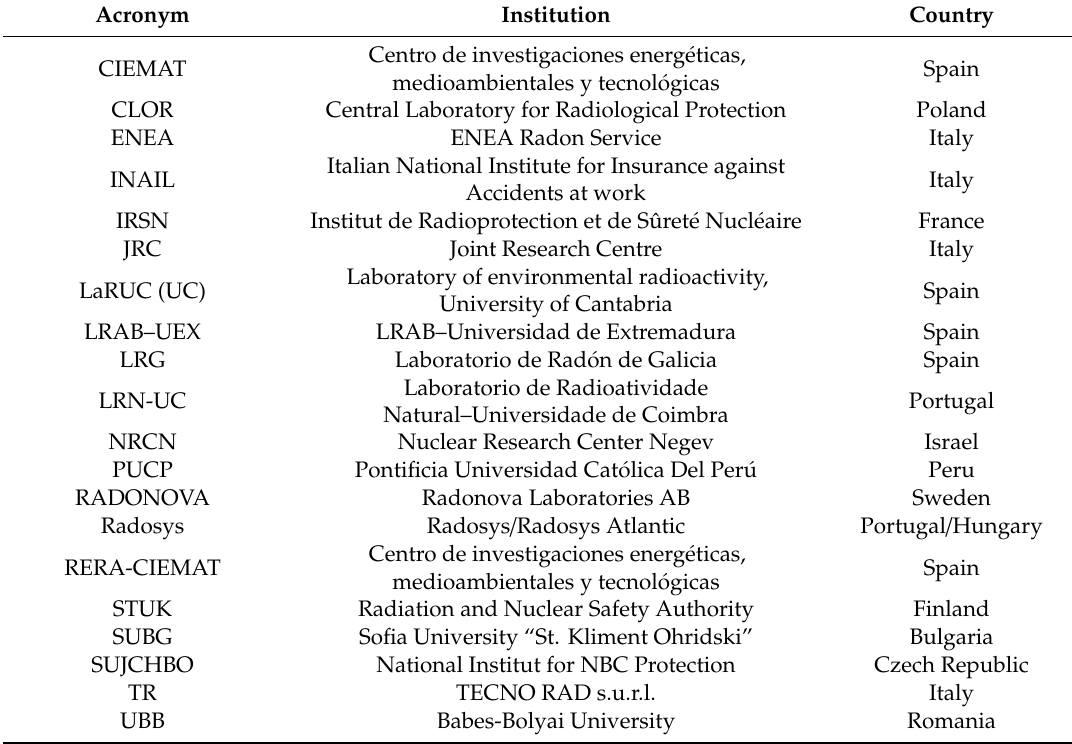
Table 1. Participants in the intercomparison sorted by alphabetical